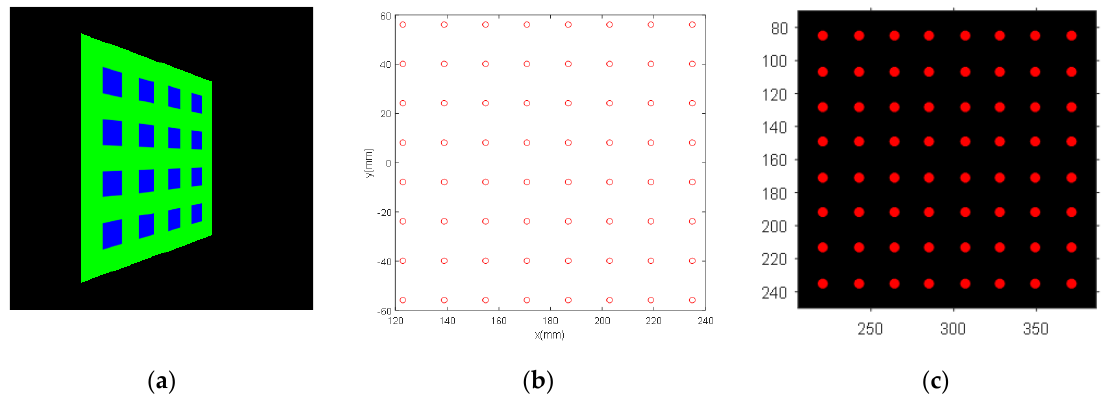
Figure 5. Examples of WAI sampling via structured light projection. ( a ) A preset structured light pattern in the projector. ( b ) Distribution of WAI sampling points. ( c ) Control point distribution on the image plane, where the points correspond to WAI sampled points.